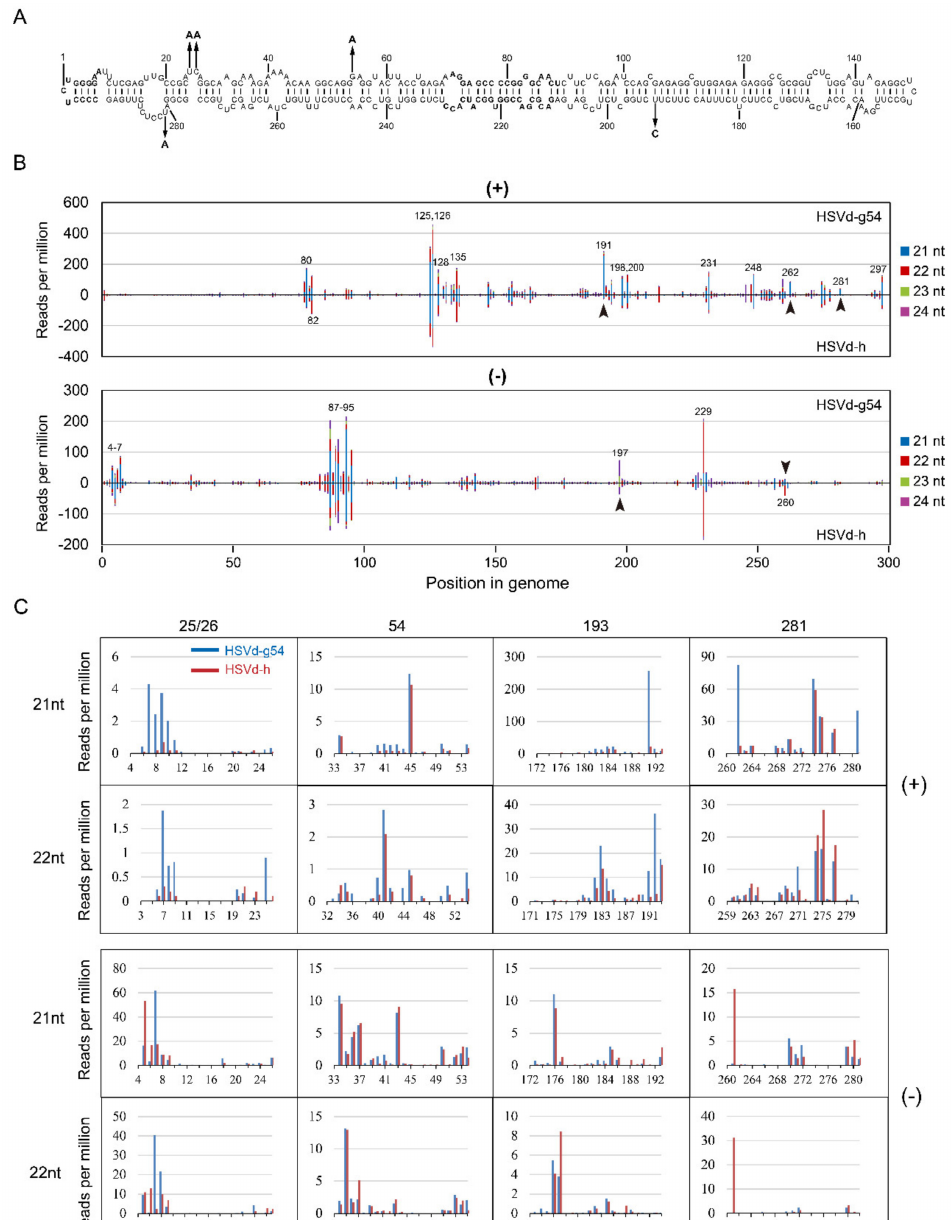
Figure 8. Sequence profiles of HSVd-sRNA derived from the genomic ( + ) and anti-genomic ( − )-strands of HSVd-g54 or HSVd-h in cucumbers at 28 dpi. The top panel ( A ) shows the predicted secondary structure of HSVd-g. The five hop-adaptive mutations between HSVd-g and HSVd-h are indicated by the arrows. sRNA distribution profiles shown in panel ( B ) represent the sum of 21–24-nt HSVd-sRNA populations recovered from cucumber plants infected with HSVd-h or HSVd-g54 plotted along the linearized HSVd genome (nucleotides 1–297 from left to right). sRNA distribution profiles of HSVd-g54 and HSVd-h are compared for genomic (upper panel) and anti-genomic (lower panel) strands. Genome positions of selected hot-spot peaks are marked by corresponding numbers. Arrowheads indicate sRNAs containing adaptive mutations that distinguish HSVd-g54 from HSVd-h and accumulate to obviously di ff erent levels. Details of their amounts and sequences are shown in panel ( C